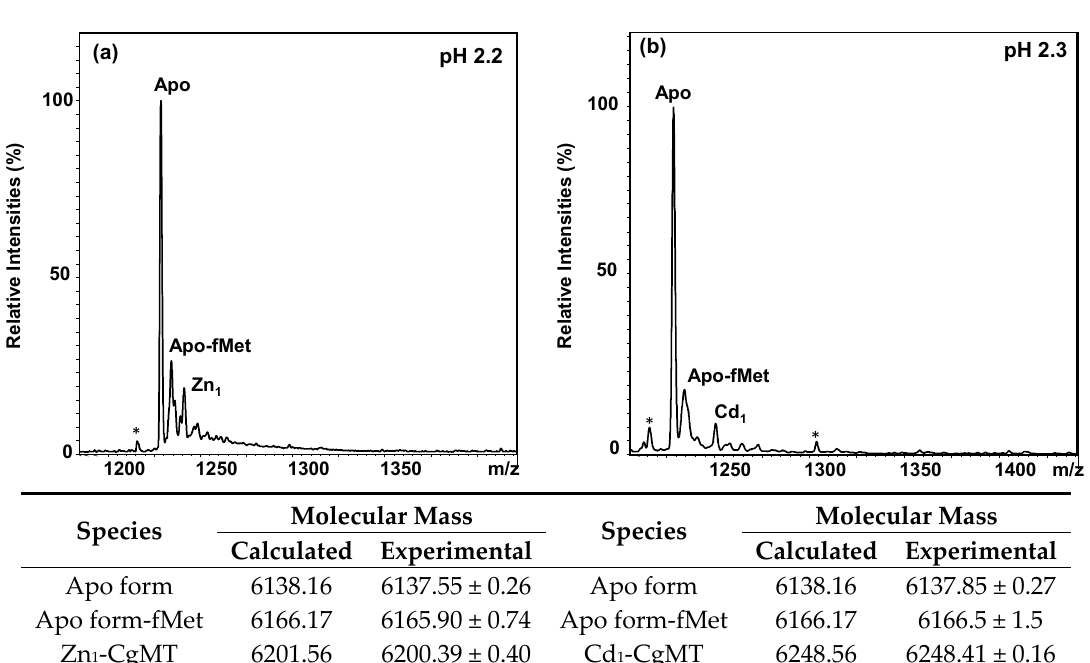
Table 1. Metal stoichiometry of recombinant CgMT protein expressed in presence of Zn(II) or Cd(II), as determined by elemental analysis (ICP-OES).